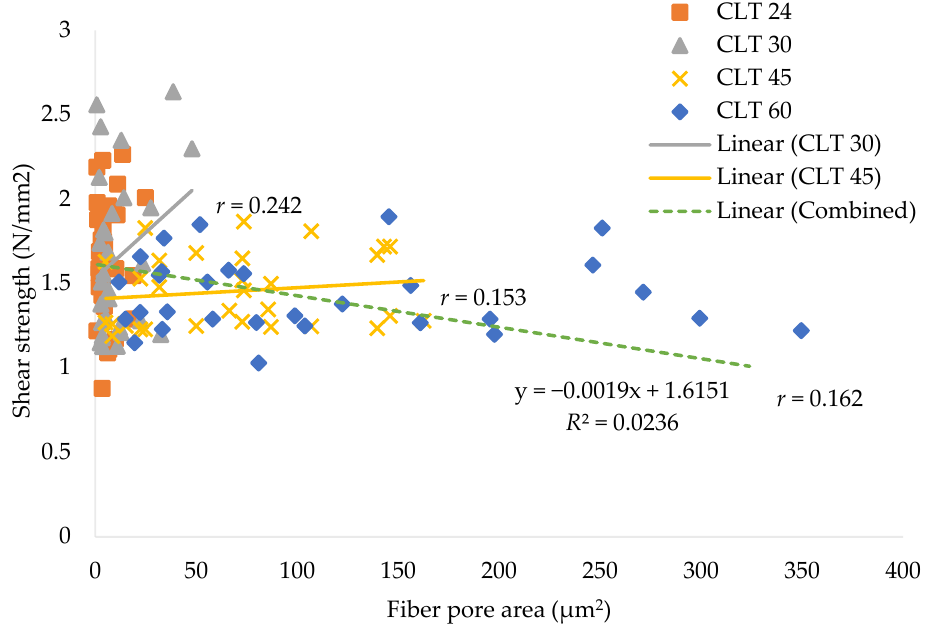
Figure 12. Correlation between the morphology (fiber pore area) of densified and undensified laminas with a shear strength of CLT panels manufactured from the laminas.